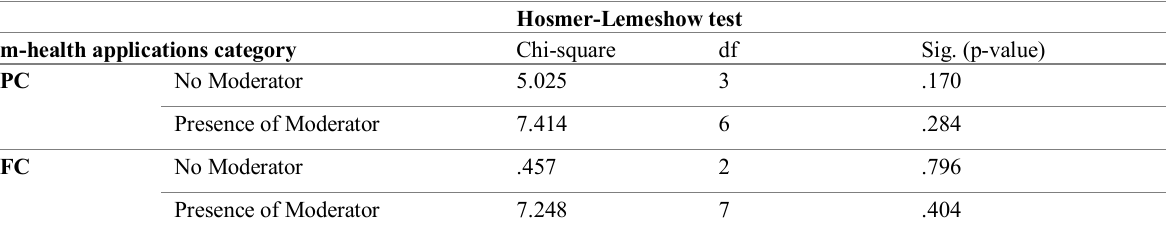
Table 7: Hosmer-Lemeshow